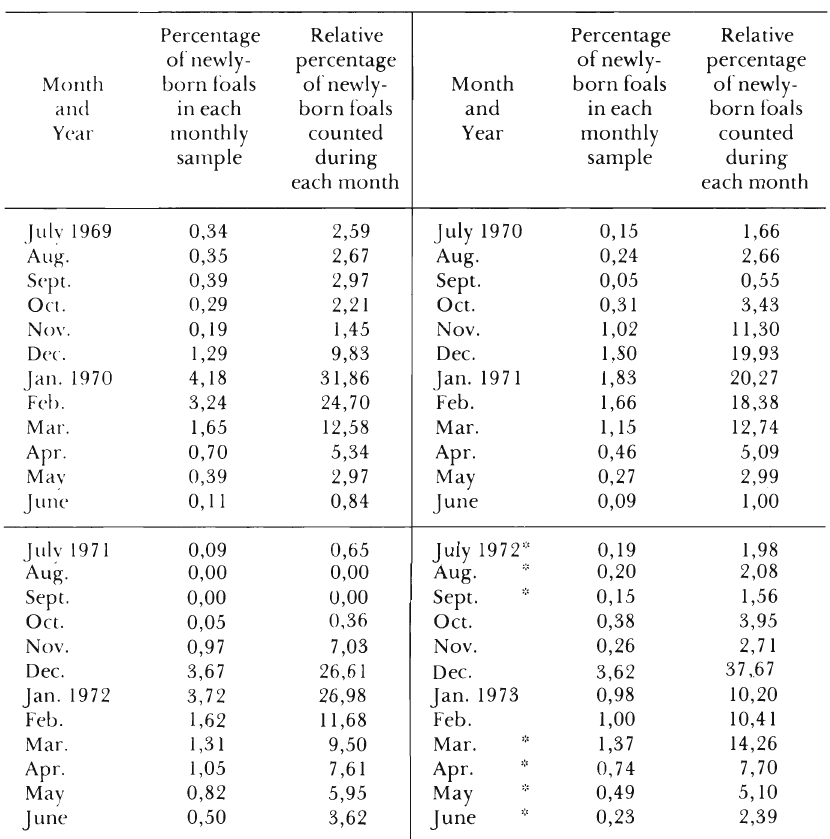
Foaling activity lor Burchell',! ubra counted at monthly intervals in the Central District oj the Kmgrr National Park between JuLy 1969 and February 1973, Counts have been divided